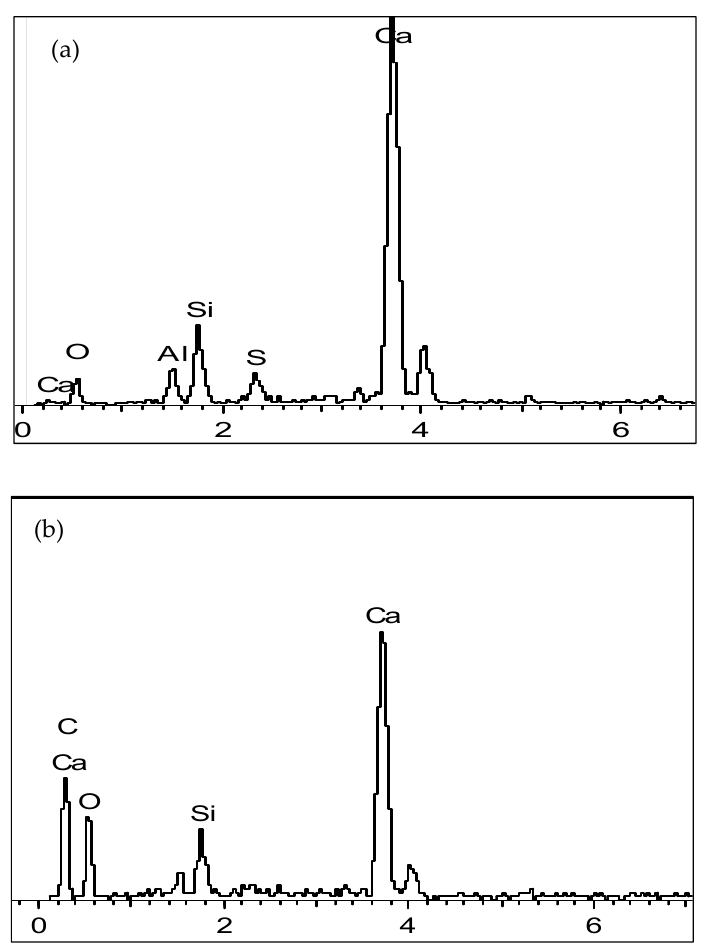
Figure 9. Comparative EDX analyses between ( a ) FCB and ( b ) B-FCB at 28.